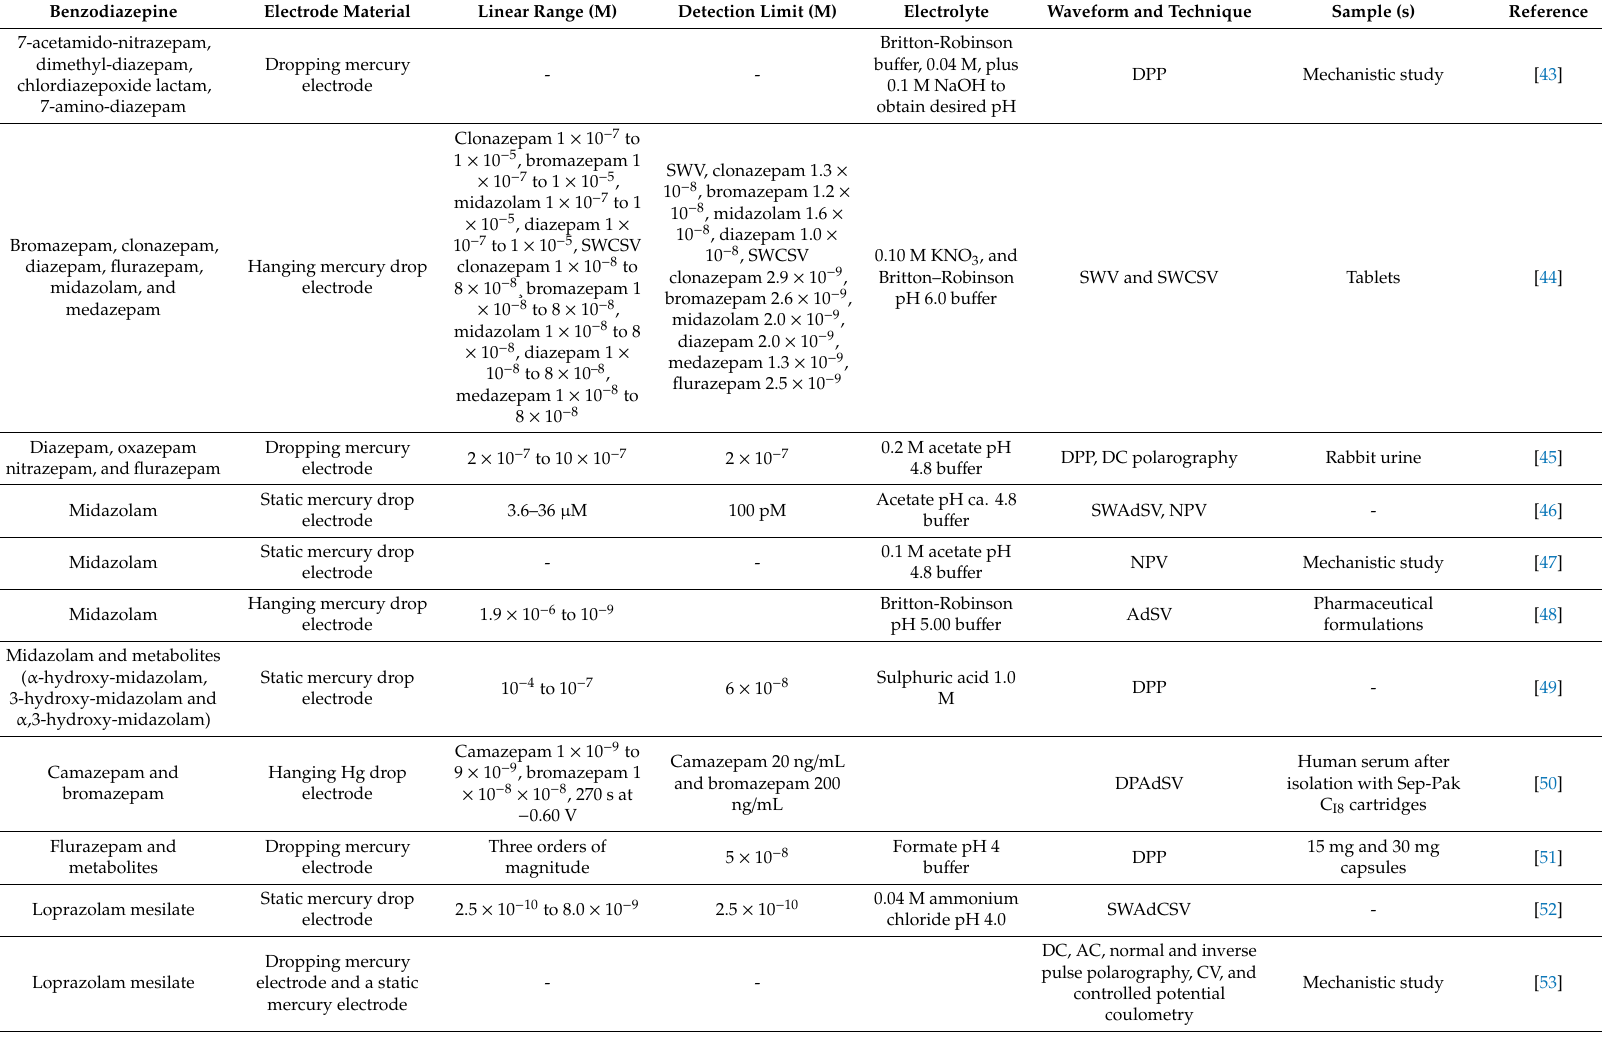
Table 1. Pre-2006 polarographic and voltammetric methods for the determination of benzodiazepines at mercury-based electrodes.